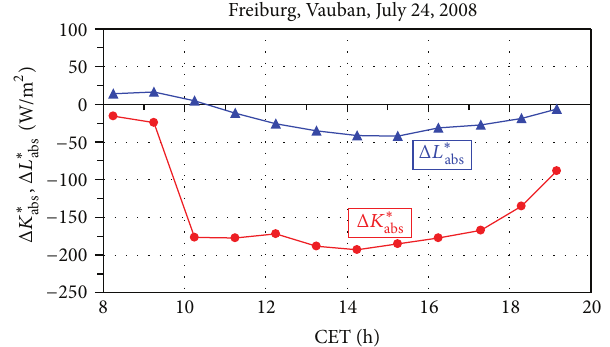
Figure22:1hmeanvaluesofdifferences Δ ofthesumsofshort-wave ) and long-wave radiant flux densities radiant flux densities ( 𝐾 ∗ abs ) from the three-dimensional environment absorbed by the ( 𝐿 ∗ abs human-biometeorological reference person between the shaded (by tree canopies) and sunny SSW-facing sidewalk of a WNW-ESE street canyon, “Vauban” quarter in Freiburg during typical Central European summer day.